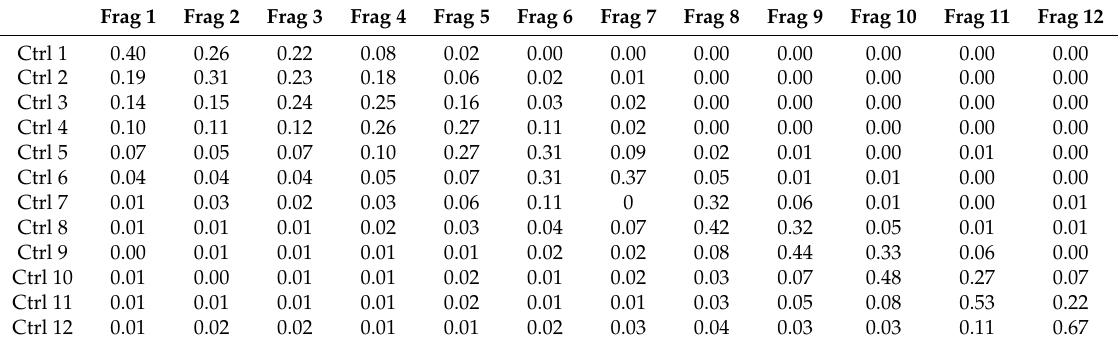
Table 5. Normalized confusion matrix of ICA for the twelve-lead ECG. The ij value of the table represent the ratio of i -th component of control patient that is paired with the j -th component of synthetically fragmented patient according to the value of